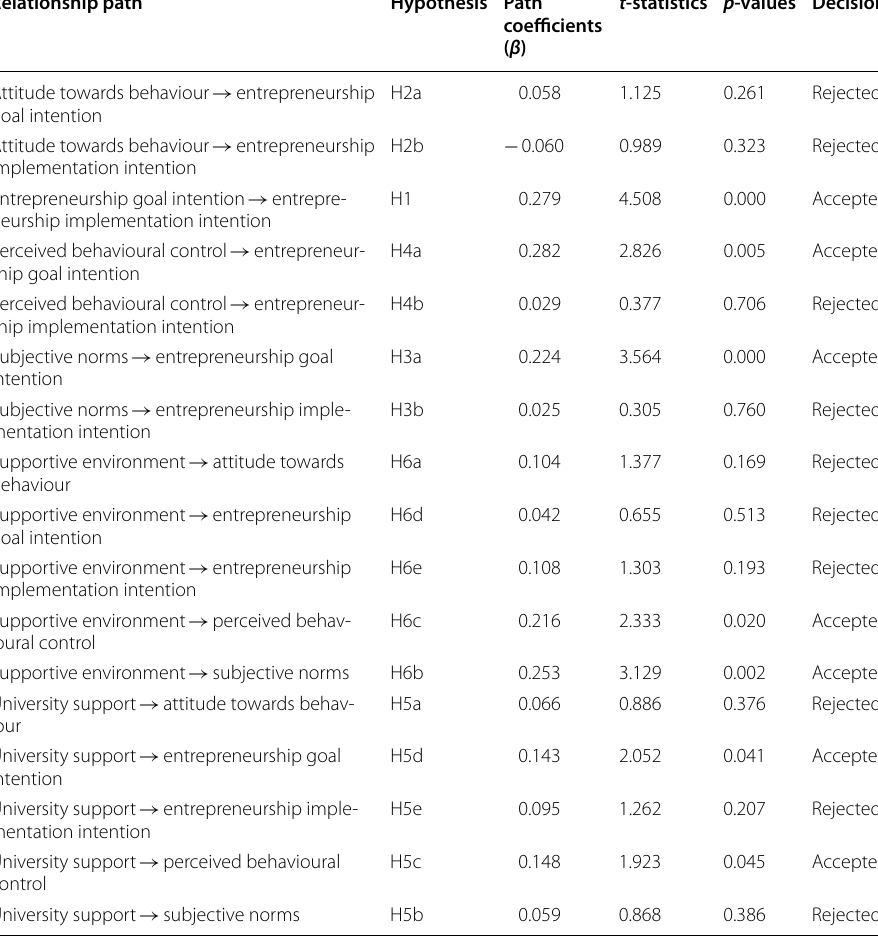
Table 3 Path coefficients for the hypothesised